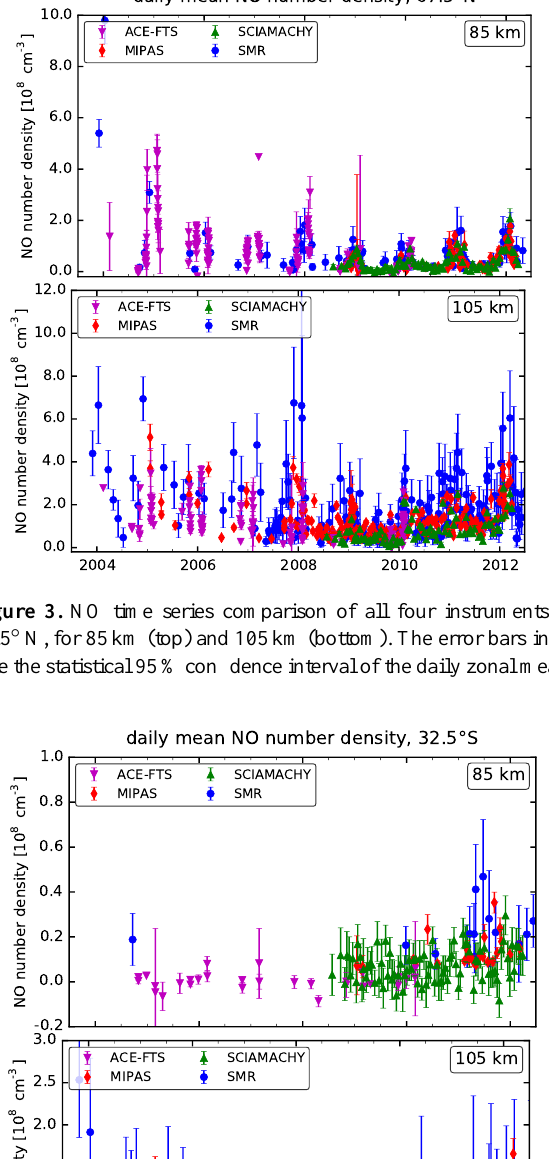
Figure 4. NO time series comparison as in Fig. 3 for 32.5 ◦ S.